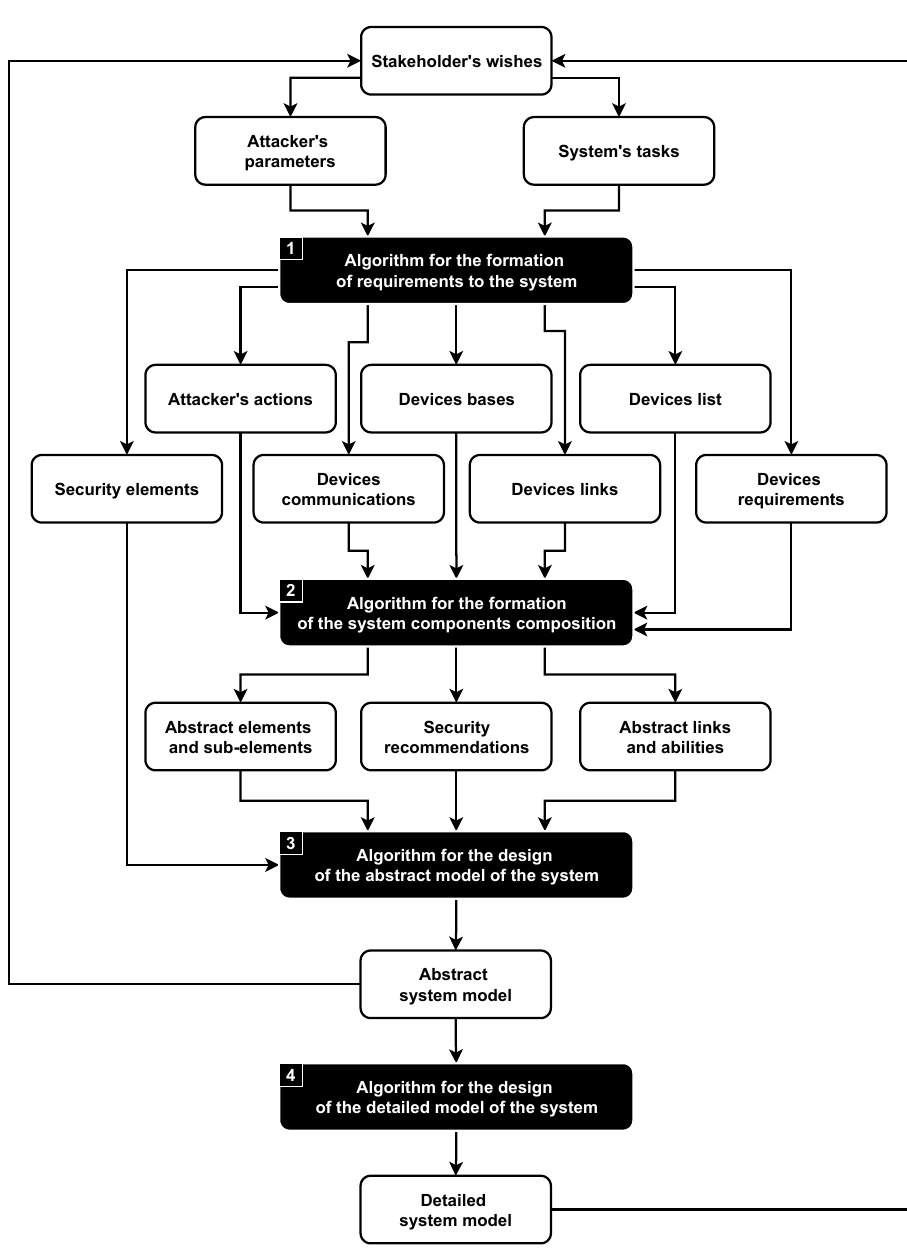
Figure 3. Methodology for the design of microcontroller-based physical security